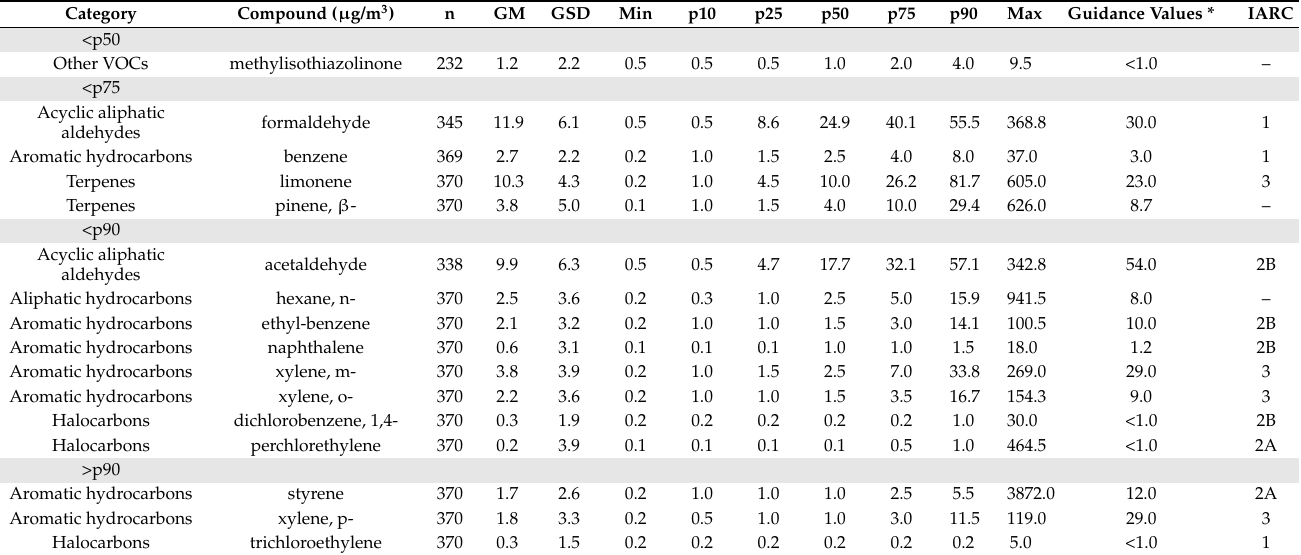
Table 1. Overview of a selection of hazardous air pollutants, by quantile of compliance with guidance